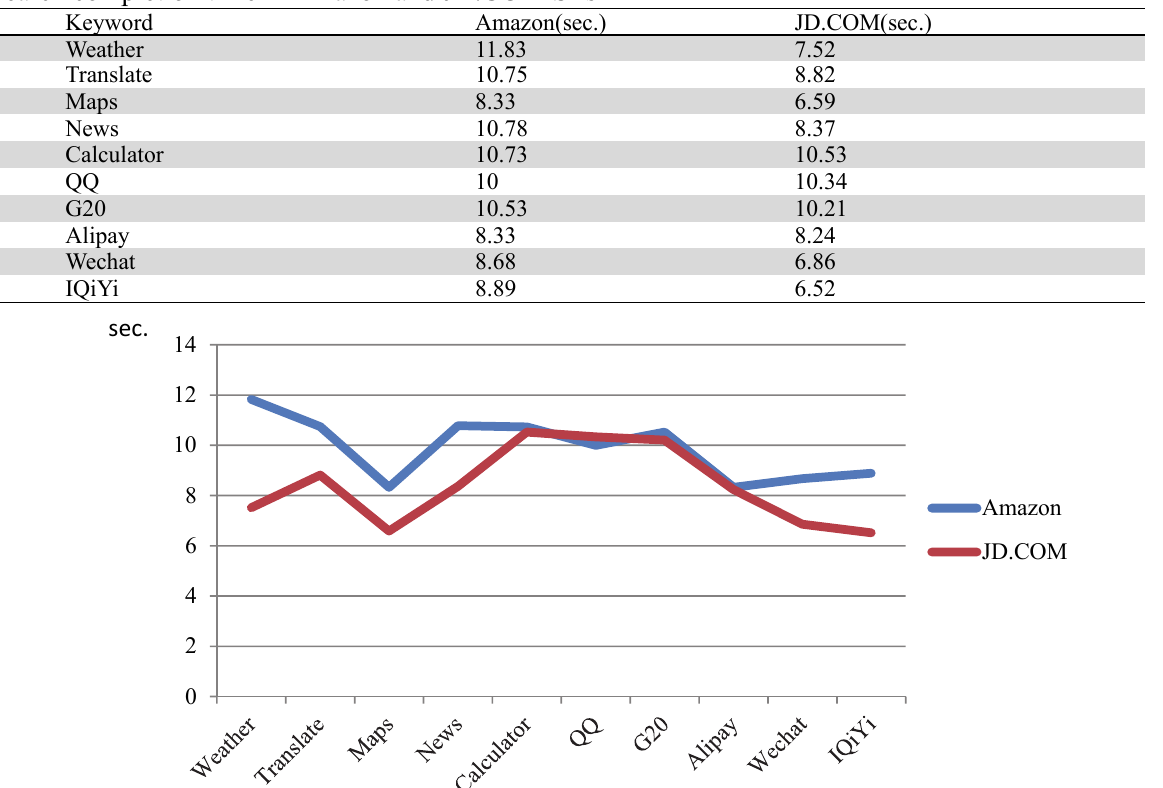
Search completion time in Amazon and JD.COM SEs